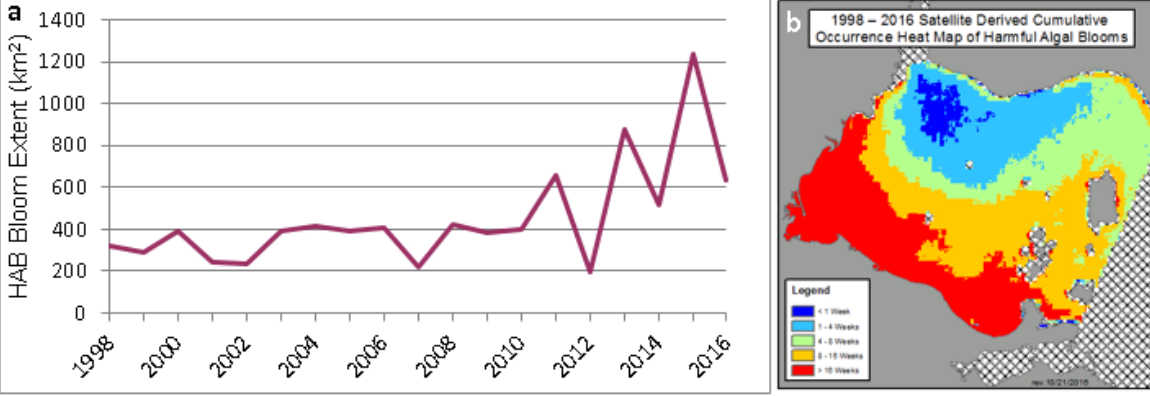
Figure 8: a) Time series of total harmful algal bloom extent from 1998 – 2016. b) Cumulative heat map of harmful algal blooms from 1998-2016. The colors indicate the length of time that each pixel has been covered by HABs over the 19-year study period. 1998-2001 data comes from SeaWiFS and 2002-2016 data comes from